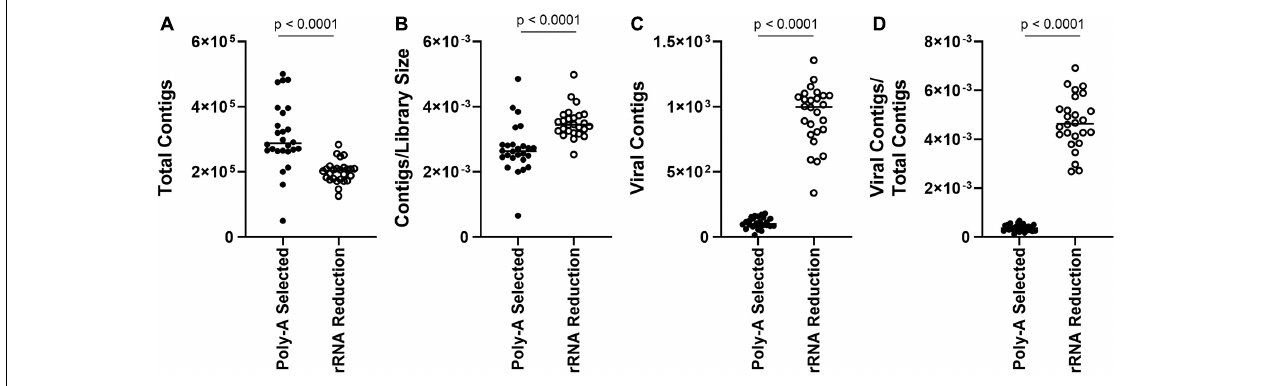
FIGURE 3 | Comparison of contigs between poly-A selected and rRNA-reduced libraries. (A) Total contigs, (B) contigs normalized to library size, (C) total viral contigs, and (D) viral contigs normalized to total contigs between the two types of libraries.